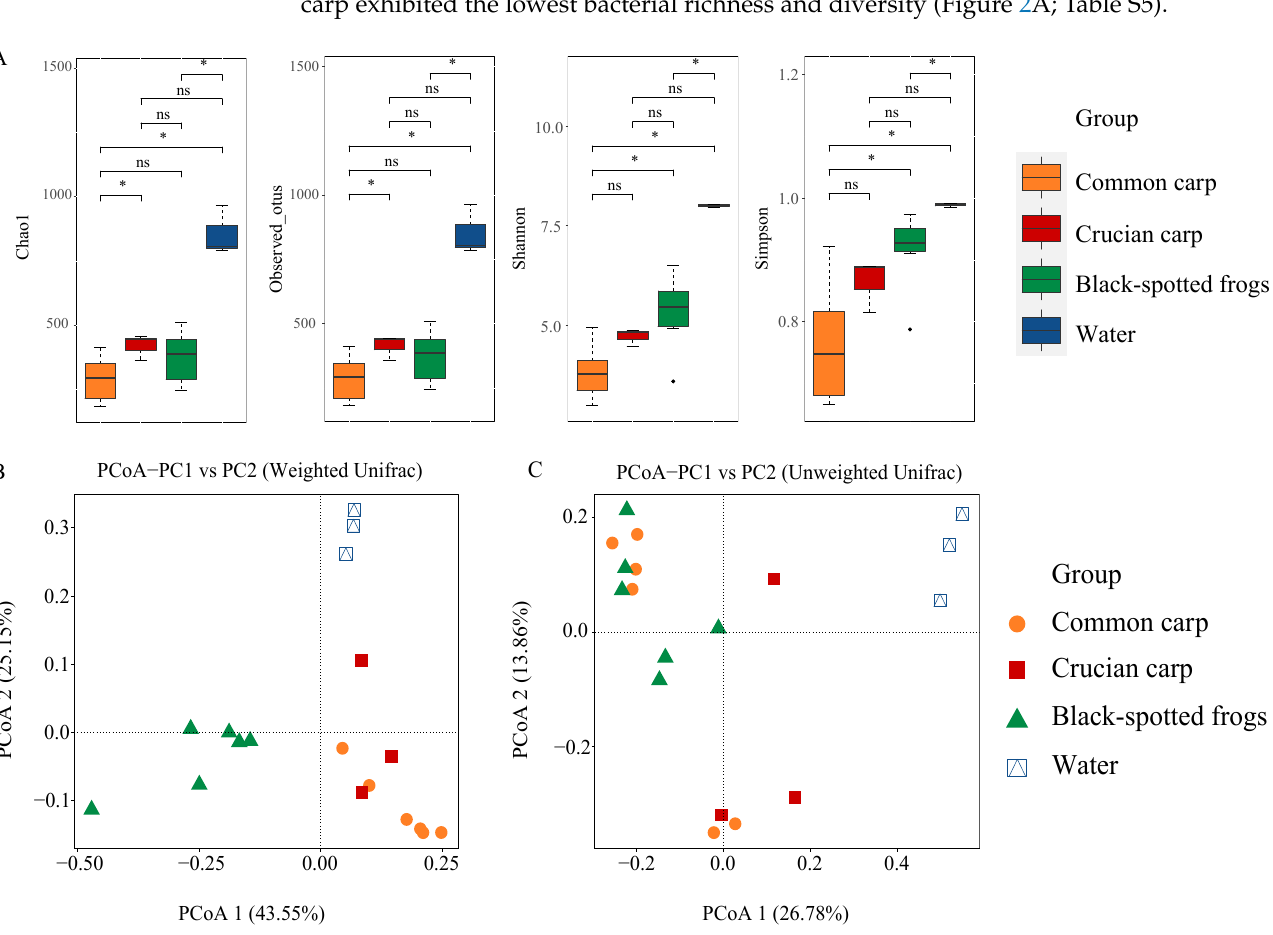
Figure 2. The alpha and beta diversity of microbial communities in common carp, crucian carp, black-spotted frogs, and water samples. ( A ) Box-and-whisker plots for comparison of alpha diversity of microbial communities between common carp, crucian carp, black-spotted frog, and water envi- ronment. “*” indicates there are significant differences ( p < 0.05) between the groups and “ns” means no significant differences. ( B ) Two-dimensional principal coordinate analysis (PCoA) of bacterial communities between the four groups based on weighted UniFrac ( B ) and unweighted UniFrac ( C ) distances. Each symbol corresponds to one sample. The first two principal coordinate (PC) axes are